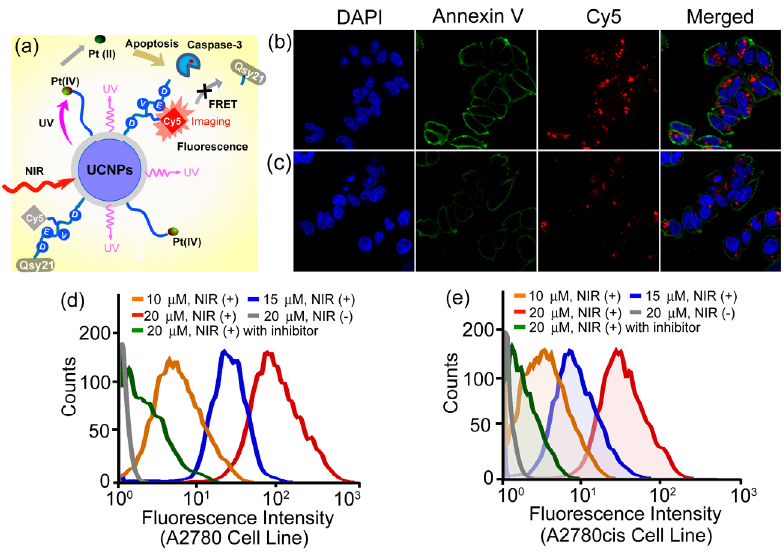
Figure 9. Live-cell apoptosis imaging for NIR irradiation of Pt(IV)-probe UCNPs@SiO